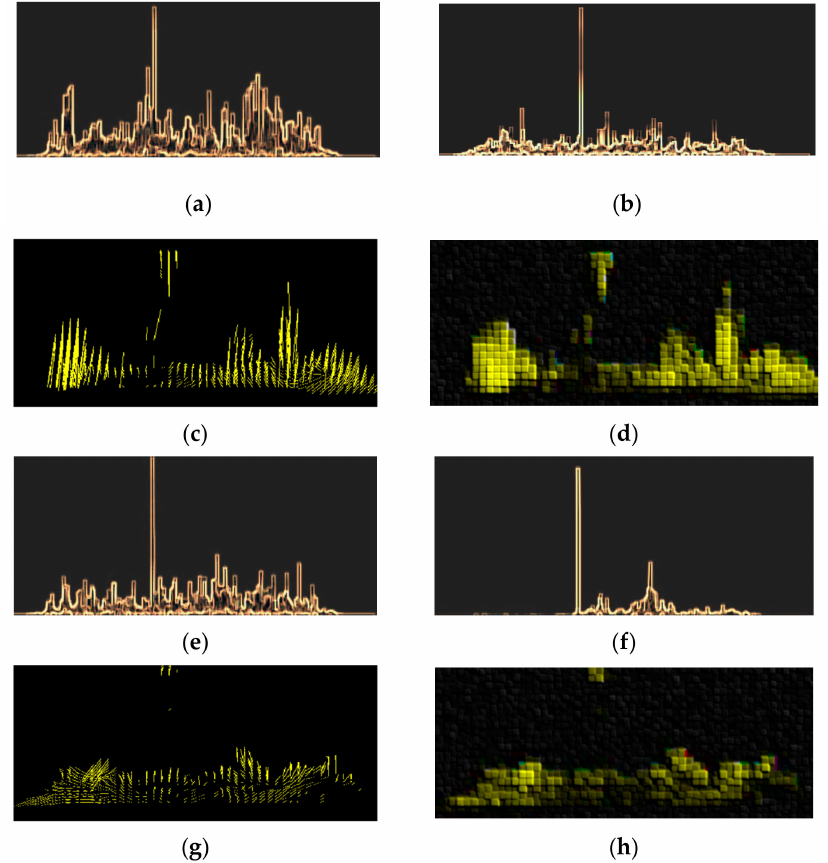
Figure 5. ( a , b , e , f ) Input spectrum graphs; ( c , g ) optical flow characteristic graphs; ( d , h ) feature graphs extracted by